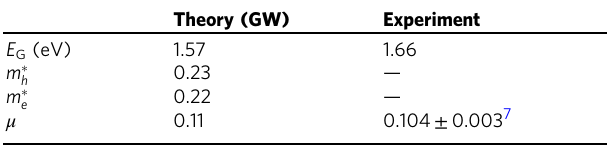
Table 1 Comparison between calculated and experimental band gap energies and effective masses Theory